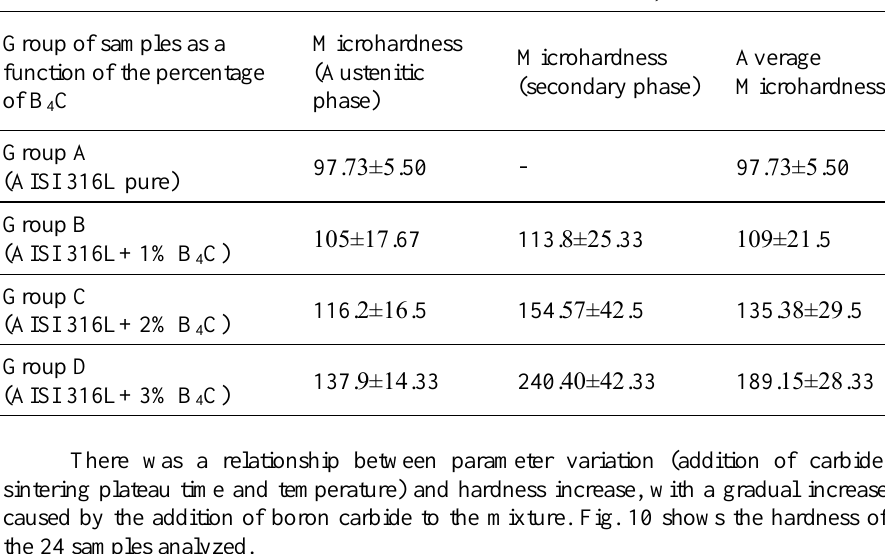
Table 6 . Vickers microhardness values HV 0,3 .